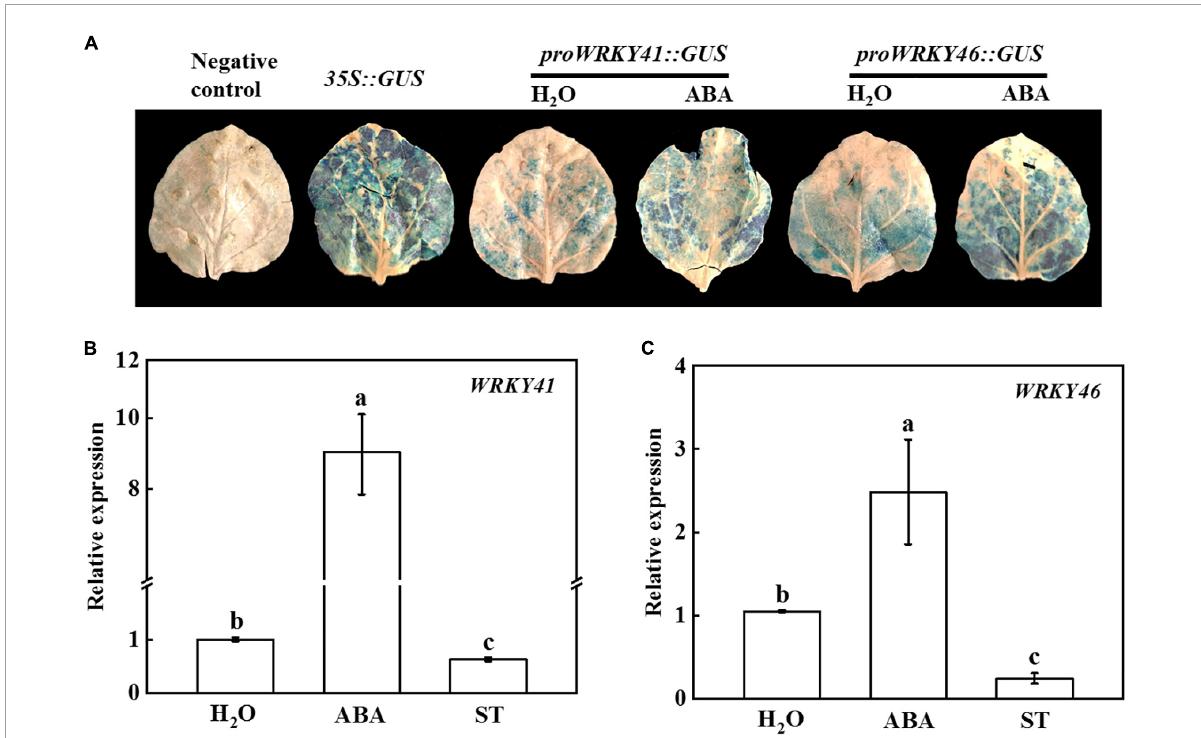
FIGURE6 Effects of abscisic acid (ABA) on the expression of WRKY41 and WRKY46 . (A) Transient GUS expression in tobacco leaves showing ABA inducing the expression of WRKY41 and WRKY46 . Agrobacterium tumefaciens harboring the indicated plasmids were infiltrated into tobacco leaves, and the leaves were treated with 100 µ mol ABA after infiltration for 1 d, and the GUS staining was performed after injection for 2 d. (B) Effects of ABA on the expression of WRKY41 in cucumber leaves. (C) Effects of ABA on the expression of WRKY46 in cucumber leaves. Cucumber plants were irrigated with 100 µ mol ABA or 1 mmol sodium tungstate (ST), and the leaves were collected at 1 d for analysis the expression of WRKY41 and WRKY46 using qPCR. The results represent the mean ± SD ( n = 3). Means with the same letter did not significantly differ at P < 0.05 according to Tukey’s